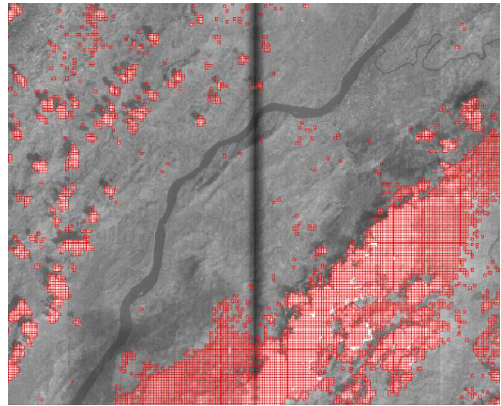
Figure 5 (a)image after correction(b)local detail before correction(c) local detail after correction The other image was obtained on September 9,2014 over Laos.The results of cloud detection are marked by red squares(Figure6).